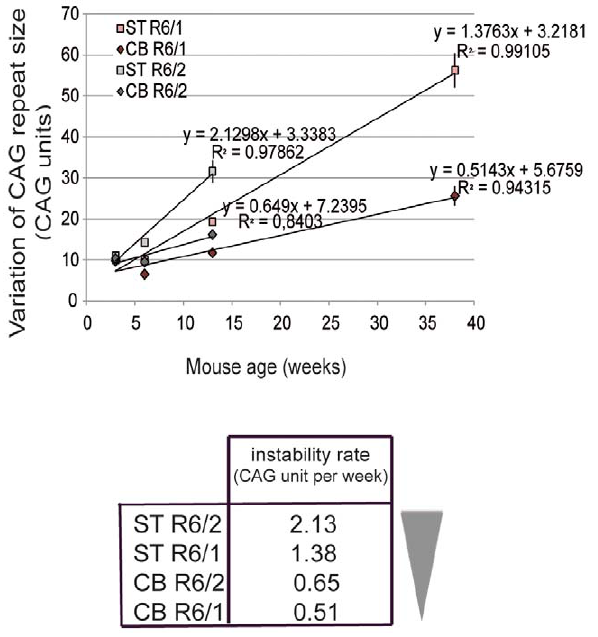
Figure 1. Somatic CAG instability rates in R6/1 and R6/2 striatum and cerebellum. Upper panel. The variation of the number of CAG repeats, a mean to assess instability, was measured over time in this study and previously [36]. The striatum and cerebellum of R6/1 and R6/2 mice were analyzed at 3 weeks, 6 weeks and 12 weeks and in addition at 38 weeks for R6/1 mice. R6/2 mice with 160 CAG repeats and R6/1 mice with 130 CAG repeats were analyzed. Error bars, sem. Instability increased more rapidly in R6/2 tissues relative to R6/1 tissues and in striatum as compared to cerebellum. Instability rates for the striatum and cerebellum of R6/1 and R6/2 mice were deduced from regression analyses, and correspond to regression coefficients. Lower panel. Ranking of instability rates according to mouse line and